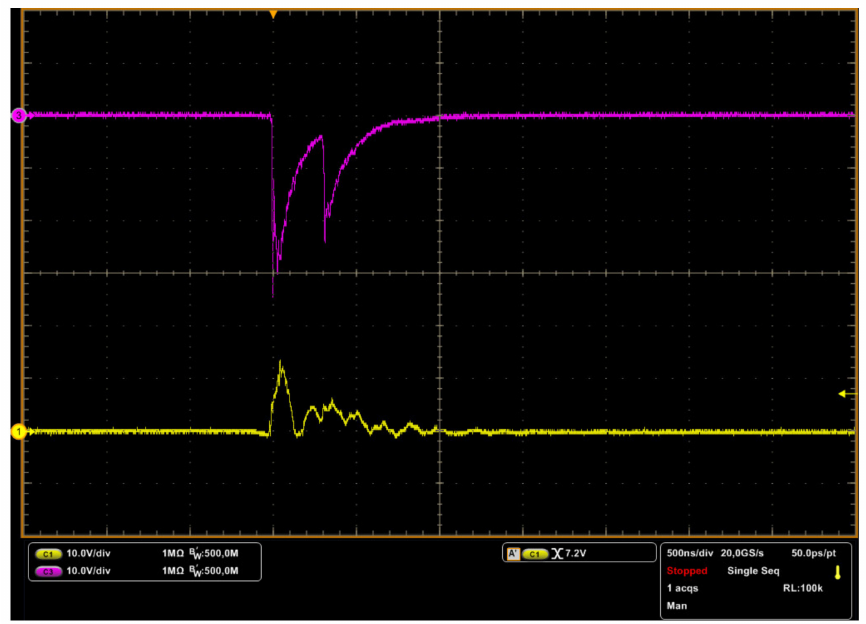
Figure 12. Oscillograms of current impulse of third type on the model antenna (yellow signal), discharge current from the solid stripe electrodes (magenta signal) (shunts 0.5 Ohm).